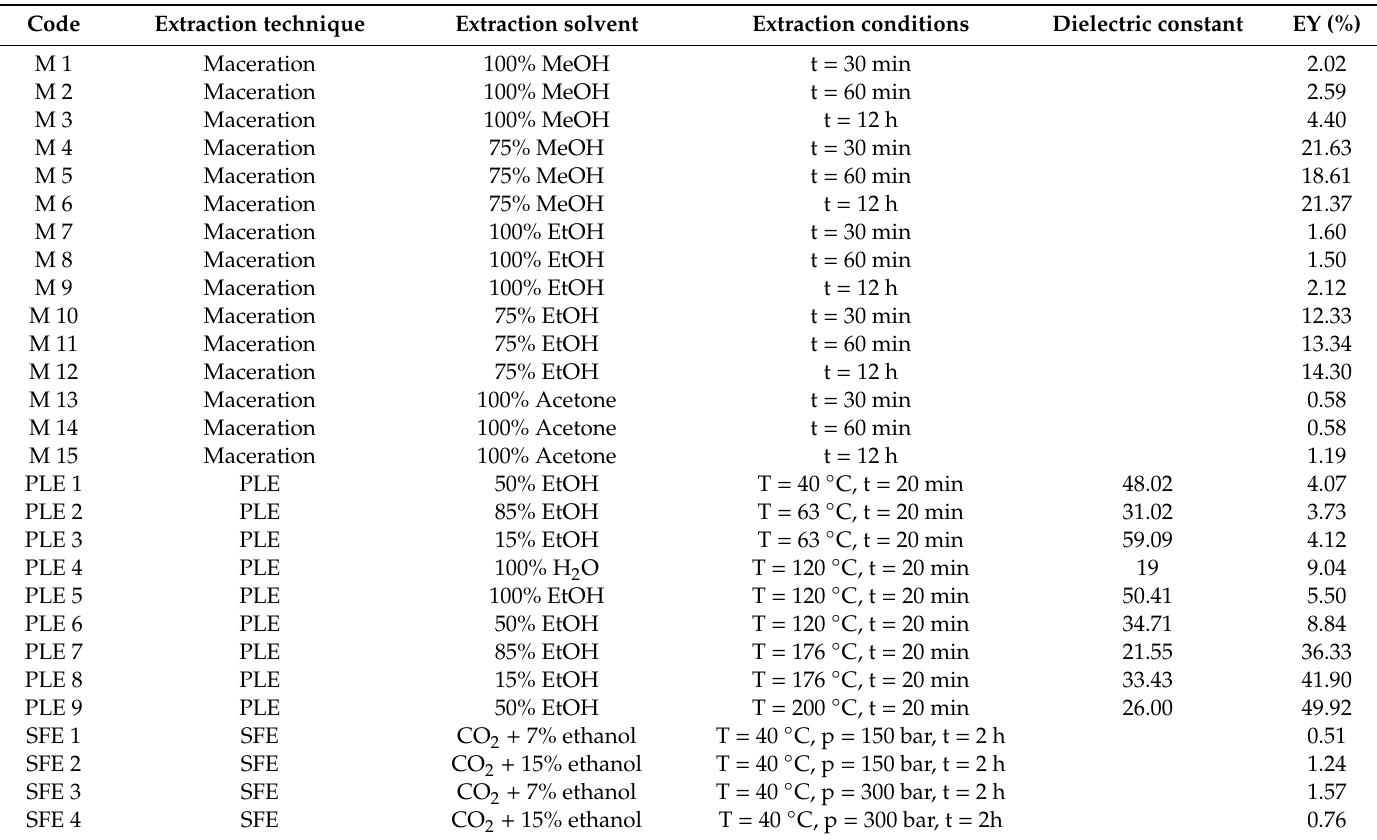
Table 2. Extraction yield obtained for S. o ffi cinale root using di ff erent extraction techniques performed in di ff erent extraction conditions.